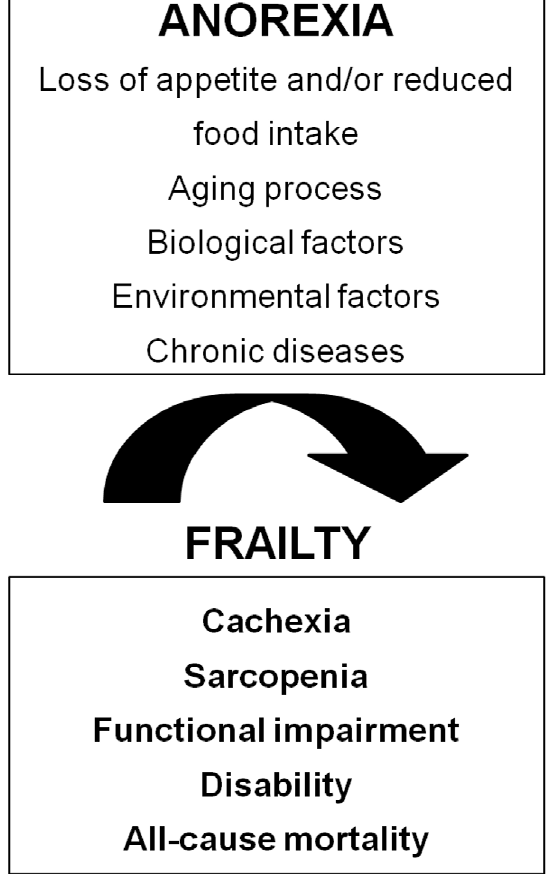
Figure 1. Anorexia as a geriatric